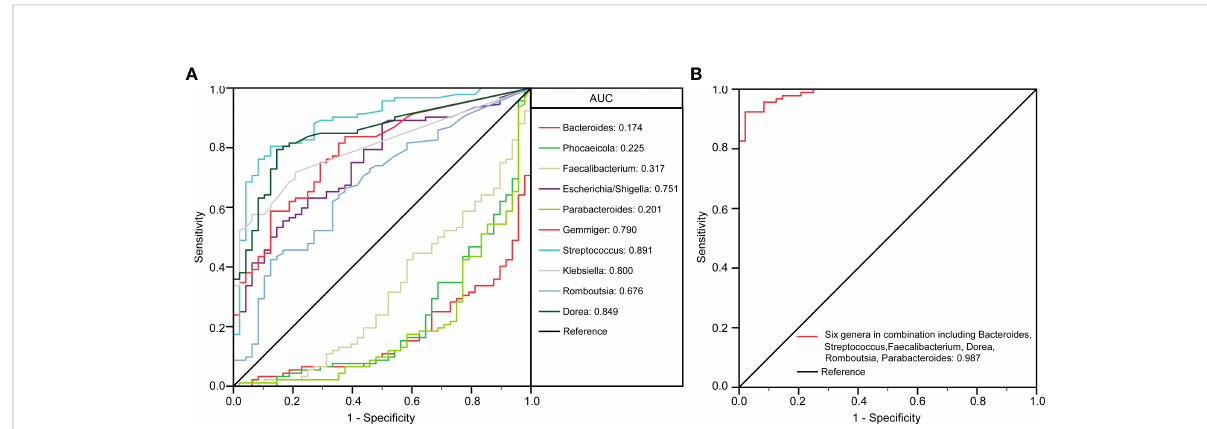
FIGURE 5 The differential genera as childhood MDD diagnostic markers. Receiver operating characteristic (ROC) curves for the differential genera such as Bacteroides , Phocaeicola , Faecalibacterium , Escherichia/Shigella , Parabacteroides , Gemmiger , Streptococcus , Klebsiella , Romboutsia , Dorea alone (A) or in combination including Bacteroides , Streptococcus , Faecalibacterium , Dorea , Romboutsia and Parabacteroides (B) used to discriminate childhood MDD patients from healthy controls. AUC, the area under the receiver operating characteristic